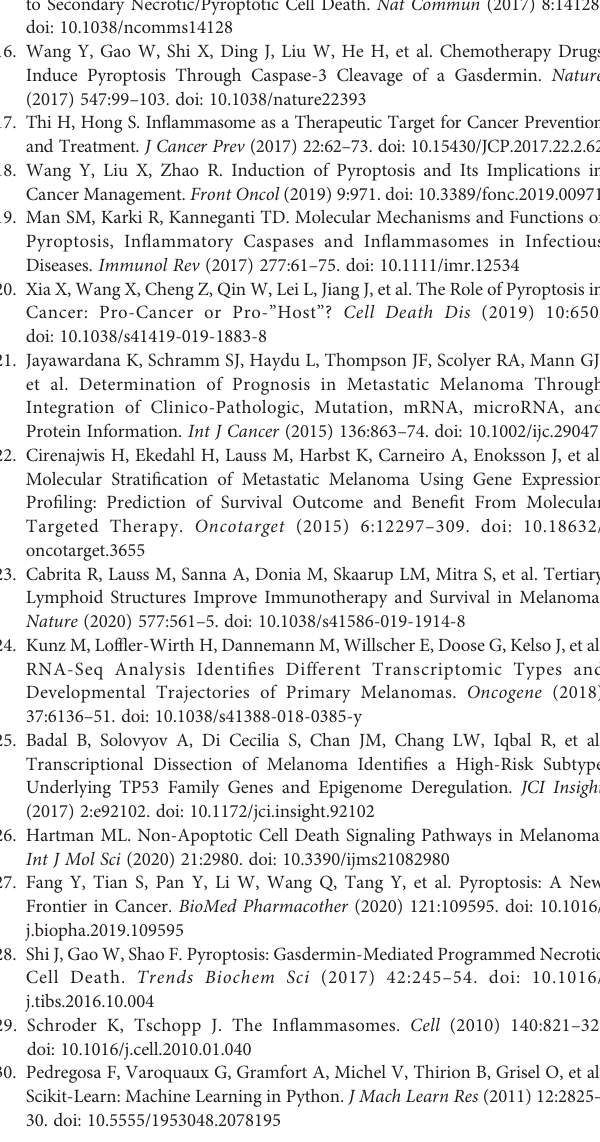
Supplementary Figure 4 | Distribution of patients based on the risk score. (A – C) Distributionofpatientsbasedontheriskscoreintrainingset (A) ,testing set (B) ,and validation set (C) . (D – F) Distribution of survival time based on the risk score in training set (D) , testing set (E) , and validation set (F) . Supplementary Figure 5 | Analyses of immune microenvironment. (A) Proportional histogram of the percentage of each immune cell. (B) Heatmap showing the amount of each immune cell in patients of TCGA-SKCM. (C) Heatmap showing the relationships among immune cells (the increasing depth of red means higher signi fi cance). Supplementary Figure 6 | Comparison of the immune microenvironment between subgroups. (A) Violin plot showing the relationship between the risk score and immune fractions. The red color represents the high-risk subgroup while the blue color represents the low-risk subgroup. (B – E) KM curves showing the relationship between cumulative survival and immune cells in signi fi cantly different in fi ltrating levels, including activated CD4+ memory T cells (B) , gd T cells (C) , M1 macrophages (D) , and M2 macrophages (E) . HR, hazard ratio.